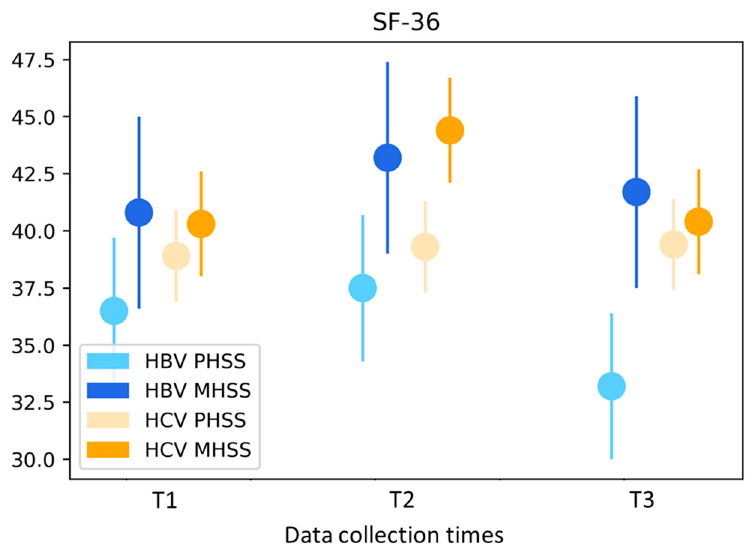
Figure 2. Short Form-36 Health Survey (SF-36)—mean values stratified by type of hepatitis and adjusted for age and gender. HBV hepatitis B virus; HCV hepatitis C virus; PHSS SF-36 Physical Health Summary Scale; MHSS SF-36 Mental Health Summary Scale.